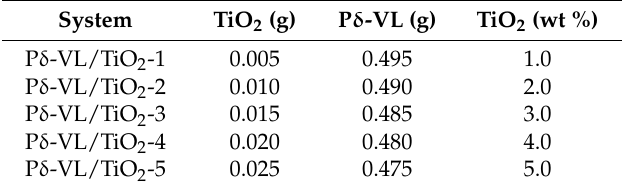
Table 1. Preparation conditions of P δ -VL/TiO 2 nanocomposites by SC and PM methods.